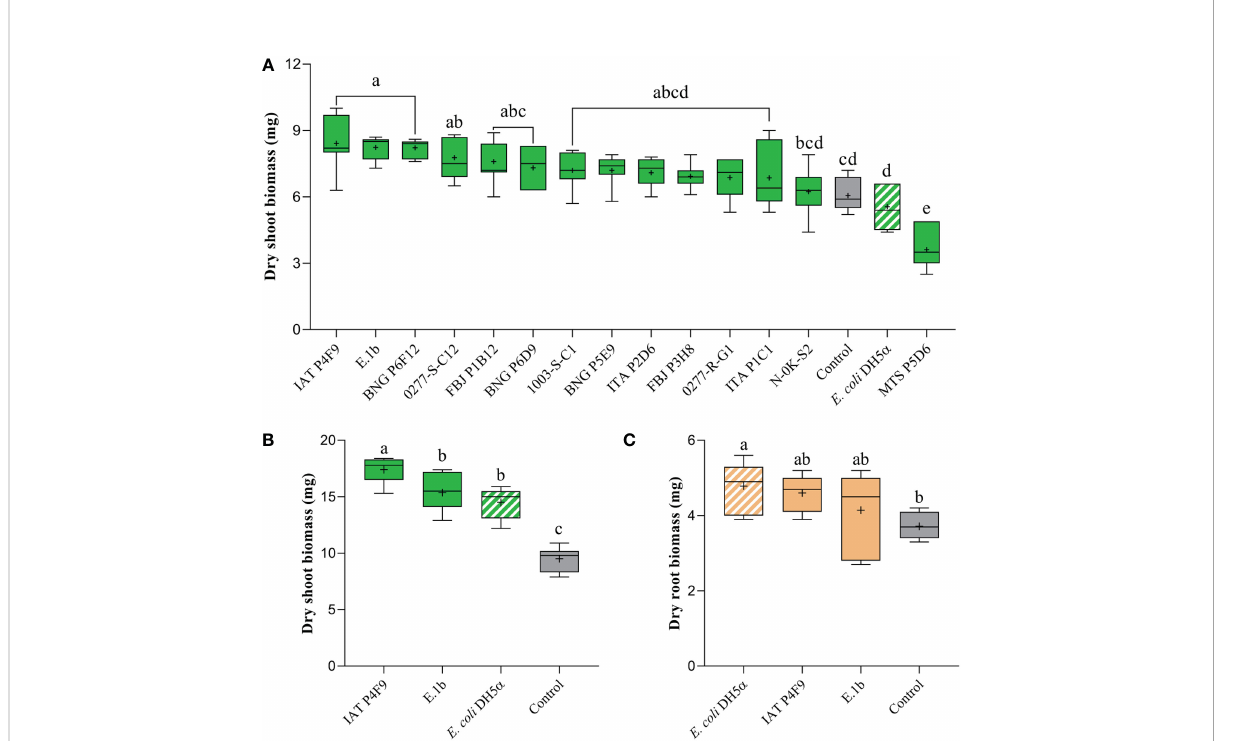
FIGURE 1 Effects of bacterial VOCs on (A) dry shoot biomass of rice plants, after 7 days of co-cultivation, and on (B) dry shoot and (C) root biomass, after 12 days of co-cultivation. Plants were co-cultivated with the bacterial isolates (full colored), the negative control E. coli DH5 a (white striped), and grown without bacteria (control, gray). Signi fi cant differences (ANOVA followed by Tukey ’ s test, p < 0.05) among treatments are indicated by letters ( n =